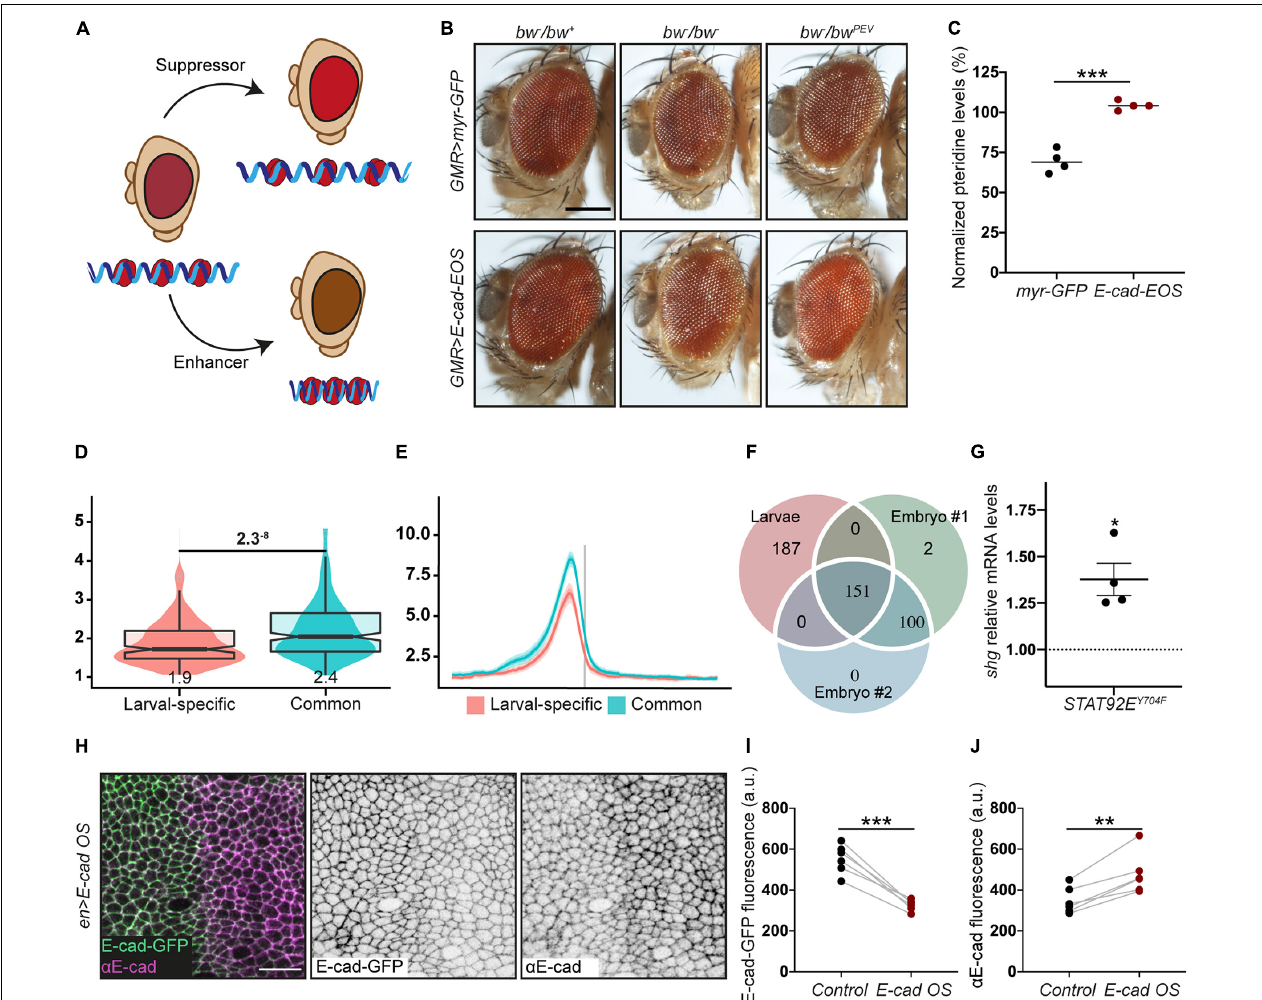
FIGURE 2 | The crosstalk between E-cadherin, STAT92E and HP1. (A) A diagram of position effect variegation (PEV) in relation to chromatin compaction. (B,C) E-cad overexpression suppresses PEV: examples (B) and quantification (C) . Scale bar – 0.2 mm, *** p = 0.0001 (unpaired t -test). (D) Overlapping box-and-violin plots showing the quantification of rBEADS normalised HP1 signal on larval-specific (red) and common (blue) promoters. The p -value above – the significance calculated using U -test. The value below the boxplots – the mean of the signal. (E) The distribution of the rBEADS normalised HP1 signal over transcription start sites (TSS) loci of larval-specific (red) and common (blue) genes. The vertical grey line represents the location of TSS, the plots span 1 kb upstream and downstream from annotated TSS. (F) A Venn diagram showing the overlaps between peak loci in the larval dataset and two independent embryonic (16–24 h) replicates. All three peak sets were filtered from peaks overlapping centromeric heterochromatin clusters and non-mappable, repetitive regions, defined based on GEM mappability analyses. modENCODE peak calls have been lifted from dm3 to dm6 genome assembly to match the analyses of larval HP1 peaks. The IDR method with 0.05 p -vale threshold was used to collapse the replicates to a common, high confidence peak set. (G) shotgun expression following overexpression of non-phosphorylatable STAT92E Y704F measured using RT-qPCR and normalised to the expression of house-keeping gene RpL32 . Four biological replicates are shown as distinct dots with three technical replicates each. * p = 0.02 (one-sample t -test comparing to 1). ( H–J) E-cad-GFP expressed from the endogenous promoter is downregulated following E-cad overexpression (E-cad OS) from a heterologous UAS promoter. A representative image (H) shows endogenously expressed E-cad-GFP visualised with native GFP fluorescence (green, left; grey, middle) and total E-cad visualised with antibody staining (magenta, left; grey, right), scale bar – 10 µ m. Levels of endogenously expressed E-cad-GFP are quantified in panel (I) and total E-cad levels in panel (J) . ** p = 0.0018 and *** p = 0.0003 (paired t -test).